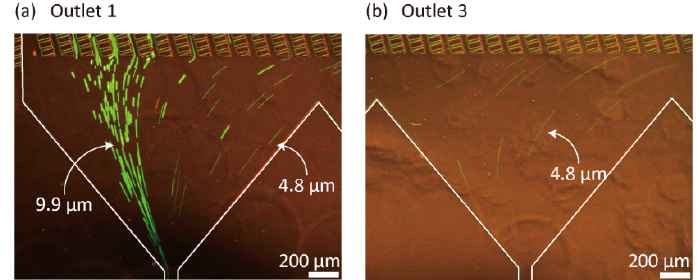
Figure 3. Behaviors of the fluorescent standard particles (4.8- and 9.9- μ m green particles) flowing near ( a ) Outlet 1 and ( b ) Outlet 3 of Microdevice A.